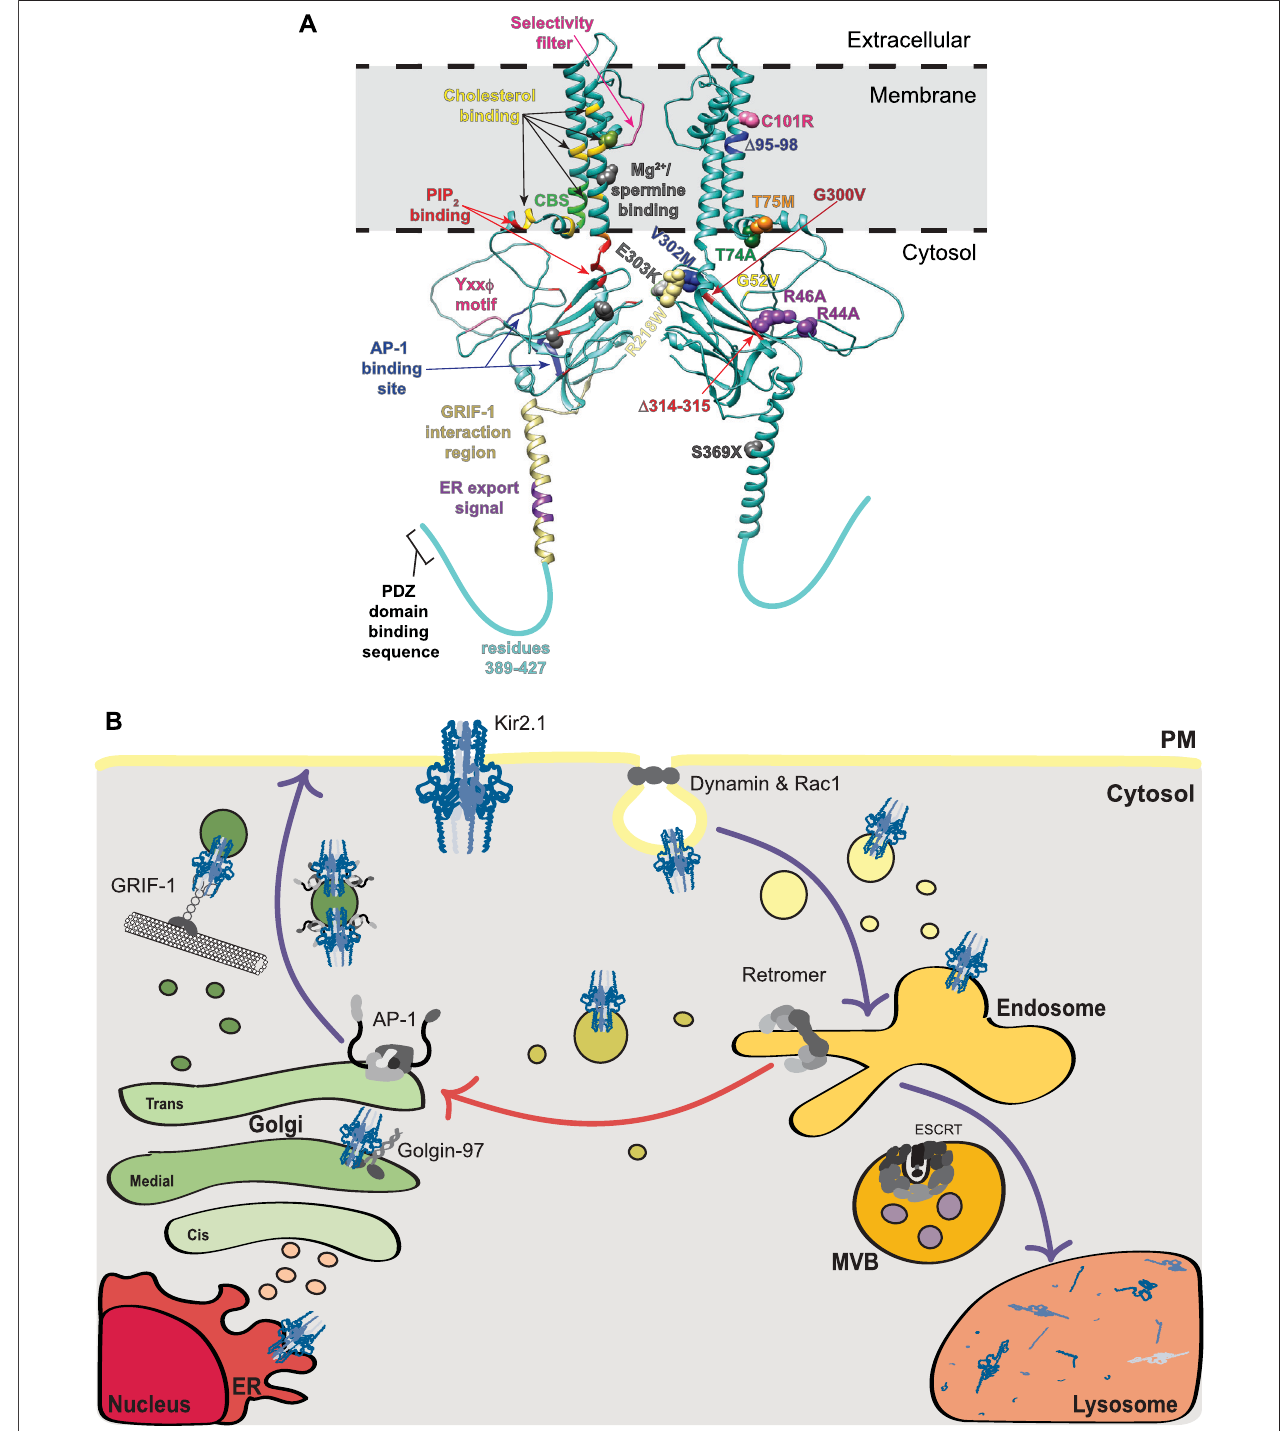
FIGURE1| Structuralmappingandtraf fi ckingmodelofKir2.1. (A) AmodelfortheKir2.1monomerwasgeneratedusingAlphaFold2(accession#P63252)(Jumper et al., 2021). Interestingly, the AlphaFold2 predicted structure for Kir2.1 reveals an extended alpha-helix spanning residues 358 – 388 that is not observed in the crystal structuresforKirchannelsasthisregionwasremovedfromtheprotein priortocrystallization.Forsimplicity,adimerofKir2.1 subunitsisshown, rather thanthetetramer that would typically exist at the PM. The left subunit on our dimer denotes binding motifs for traf fi cking factors and the right subunit highlights disease-causing mutations associated withaberrantKir2.1 traf fi cking. Left: Selectivity fi lter(pink), Mg 2+ /spermine bindingsite (gray and green where itoverlaps withacholesterol binding residue),cholesterolbindingresidues(yellowexceptwheretheyoverlapwithaMg 2+ /sperminebindingsite[lightgreen],aCav3bindingsite[darkgreen],oraPIP 2 binding